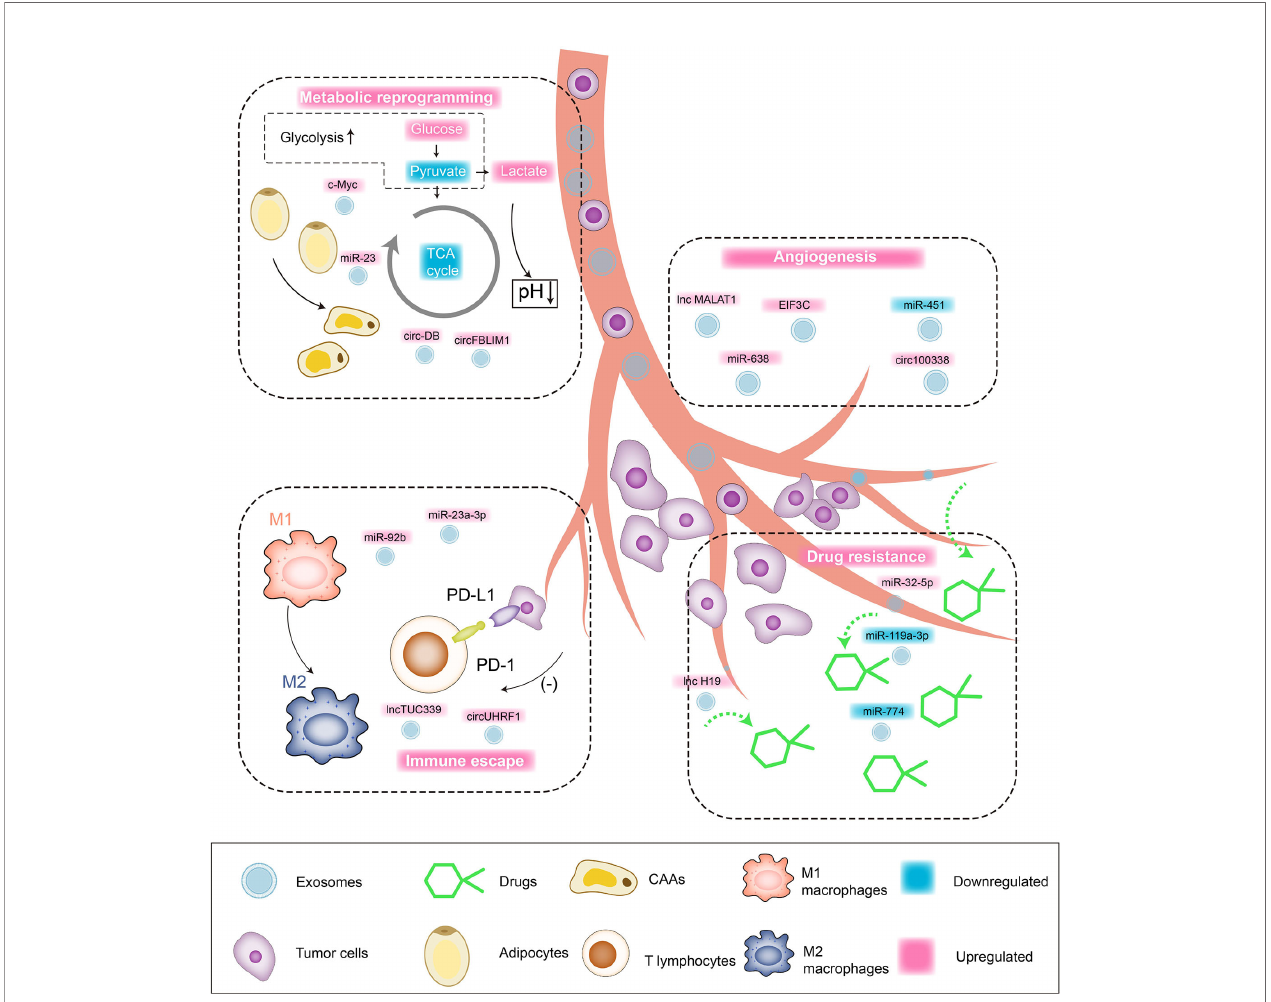
FIGURE 2 | Interaction network between exosomal ncRNAs and tumor microenvironment of HCC. Tumor cell/non-tumor cell-derived exosomes regulate the malignant biological behaviors of HCC through targeted cargo transportation. 1) Angiogenesis: upregulated lnc MALAT1, miR-638, EIF3C, circ100338 promote the angiogenesis in tumor microenvironment and HCC cell proliferation/blood-metastasis. 2) Drug resistance: upregulated miR-32-5p and lnc H19 are involved in mediating the drug resistance of HCC cells. 3) Metabolic reprogramming: upregulated c-Myc and circFBLIM1 induce aerobic glycolysis (Warburg Effect) of HCC cells. Upregulated miR-23 and circ-DB promote the transformation of fat cells into tumor-associated tumor cells (CAAs). 4) Immune escape: upregulated lnc TUC339 induces the repolarization of macrophages from M1 to M2, and the upregulation of miR-23a-3p can promote PD-L1/PD1 binding and induce T cell